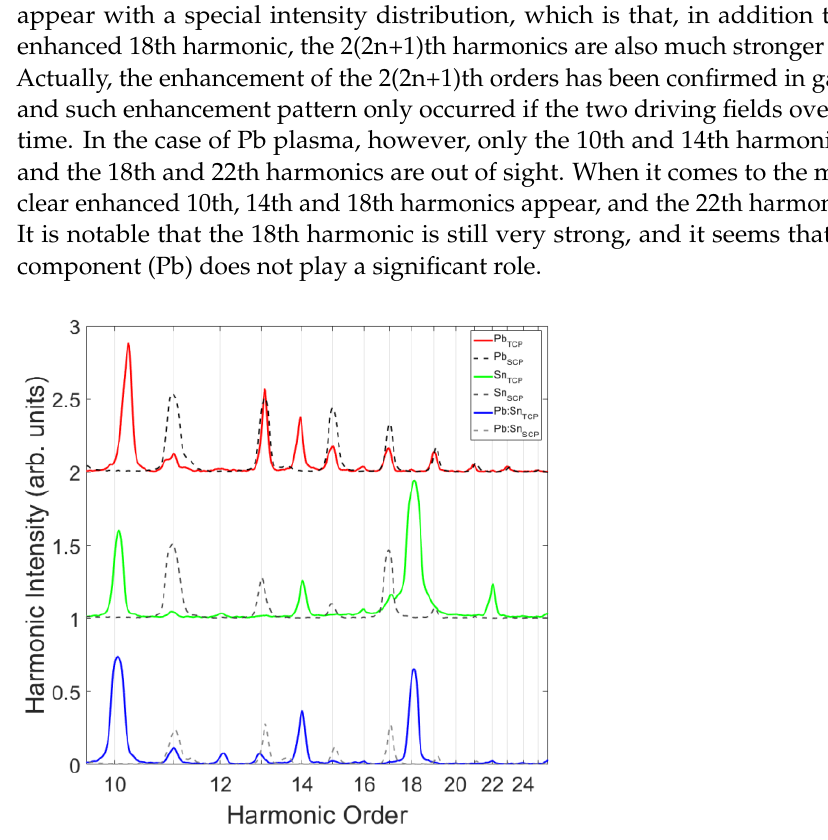
Figure 3. Two-color pump (TCP, solid lines) and single-color pump (SCP, dotted lines) spectral distributions of the harmonics generated from Pb ( upper panel ); Sn ( middle panel ); and Pb-Sn alloy ( bottom panel ) plasmas, with 800 nm, 35 fs, 100 Hz heating pulse. Vertical axis is in linear scale. For visibility, the three sets of spectra are displaced vertical from each other.